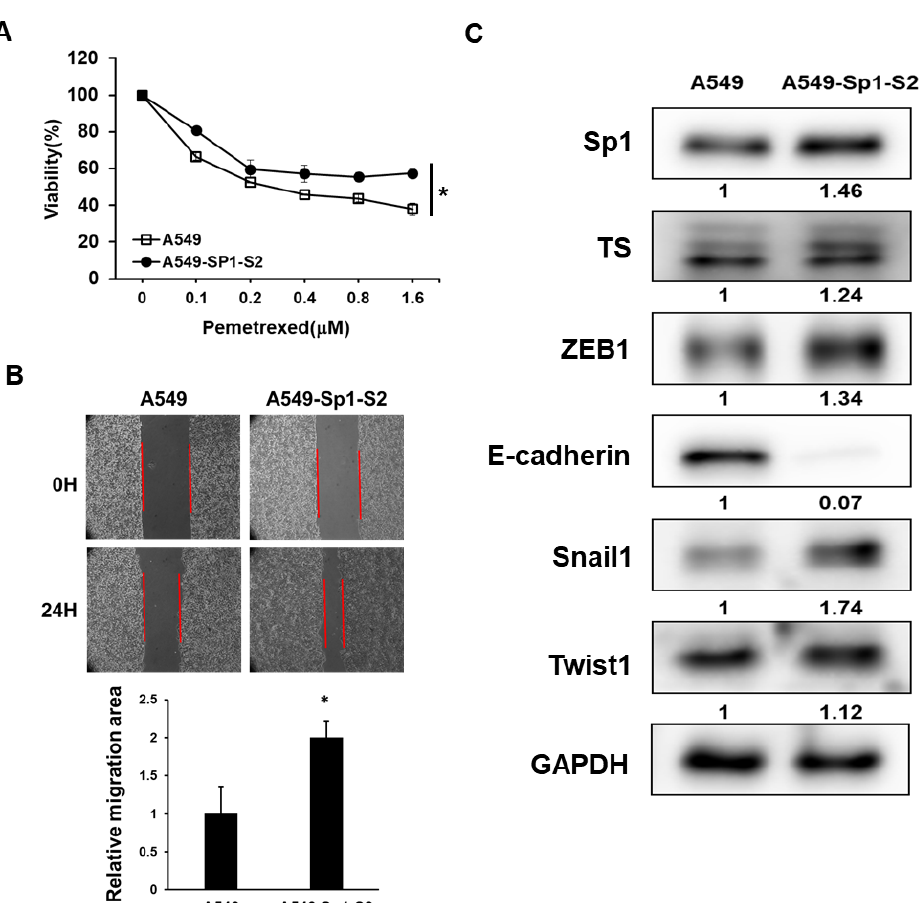
Figure 3. Forced expression of Sp1 in A549 cells decreases pemetrexed sensitivity and induces EMT. A549 cells were transfected with Sp1 cDNA containing the vector and selected with 400 µ g/mL hygromycin B to establish the Sp1 overexpressed subline (A549-Sp1-S2). ( A ) Pemetrexed sensitivity was measured by the MTT assay. ( B ) Cell migration capability was determined by the wound healing assay and the cell migration area was measured by ImageJ software (version 1.53u, National Institutes of Health, Bethesda, MD, USA) at 24 h after the removal of the inserts. Red lines indicated the forefront of cell migration. Data are presented as the relative migration area to the A549 cells. ( C ) The protein expressions of Sp1, TS, ZEB1, E-cadherin, Snail1, and Twist1 were determined by Western blotting. The inserted numbers indicated relative expression level to A549 cells. * p <